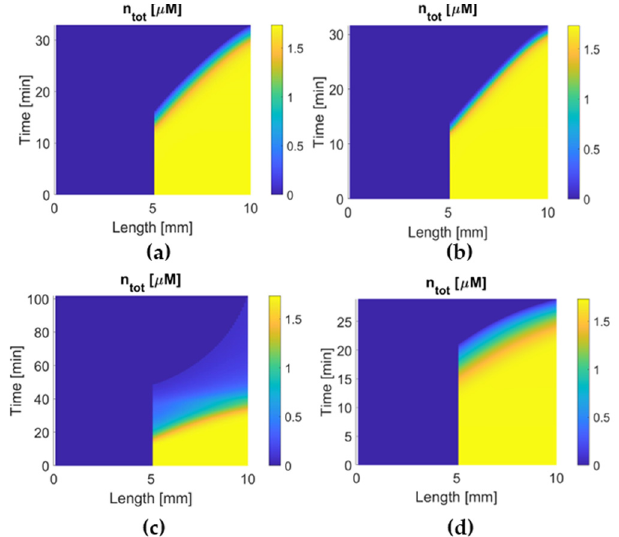
Figure 7. Temporal and spatial concentration profiles of binding sites for ( a ) alteplase, ( b ) tenecteplase, ( c ) reteplase, and ( d ) urokinase in the clot. Activation time to start lysis: tenecteplase (12 min) ≈ alteplase (12 min) < urokinase (16 min) < reteplase (18 min).